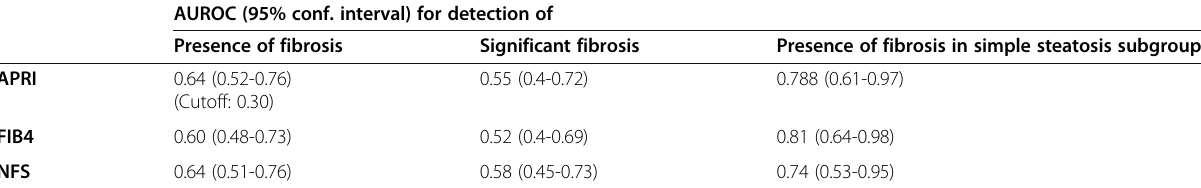
Table 4 AUROC of tested markers in detection of presence of fibrosis as well as significant fibrosis in the whole cohort and in simple steatosis subgroup AUROC (95% conf. interval) for detection